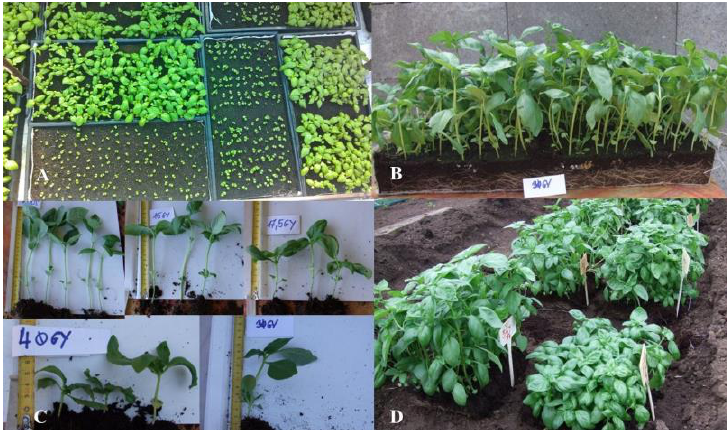
Figure 1. The fast neutron irradiation experiment of Ocimum basilicum L. at ATOMKI-DE